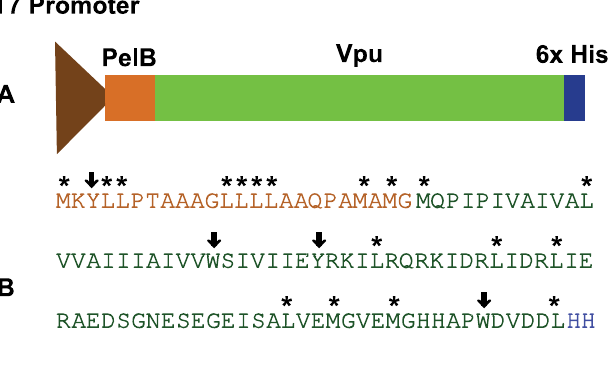
Fig 2. Organization of the expressioncassettewithin the plasmid pTM 875. Expression was driven by a T7 promoteras shown in ( A ). The Vpu gene is flankedby the PelB signalpeptideat the N-terminus that directs the protein to the periplasmic space of the bacteria and facilitates integrationinto the inner membranes, and a 6x- histidinetag at the C- terminus to aid in purification. ( B ) shows the sequenceof the PelB signal peptide(in orange),Vpu (in green) and histidinetag (in blue). Chymotrypsin cleavagesites are denotedby down-pointing arrows ( ⬇ ) for strong recognitionsites and by an asterisk ( * ) for secondary sites.